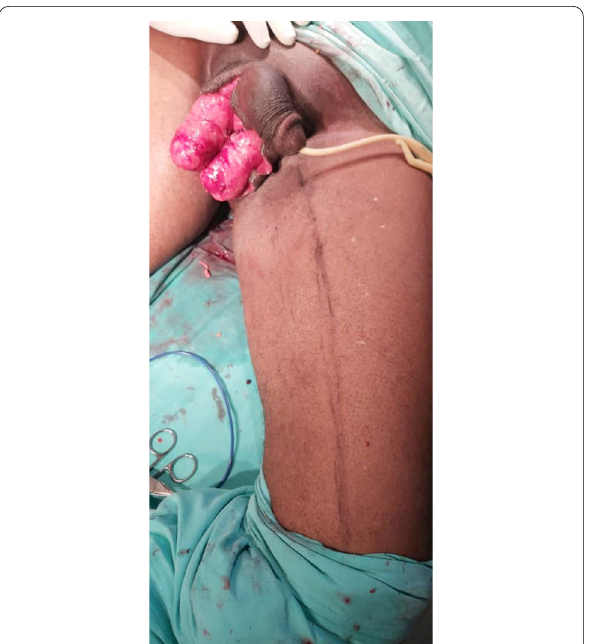
Fig. 5 The muscle flap already inset into the wound